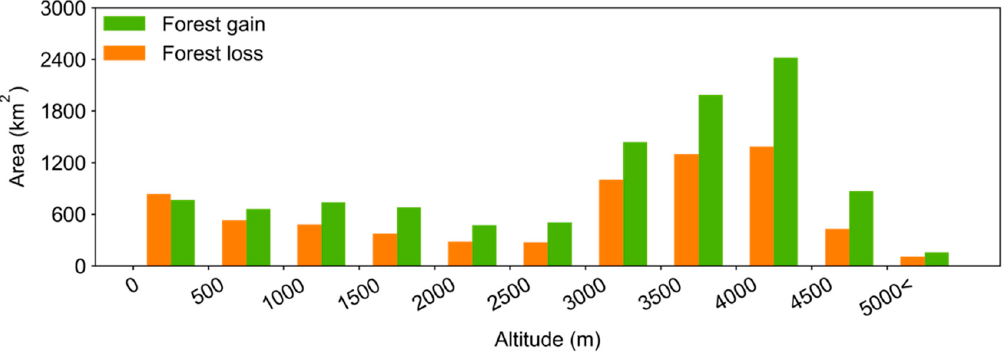
Figure 10. The area of forest loss and gain during 1990–2020 summarized by elevations.